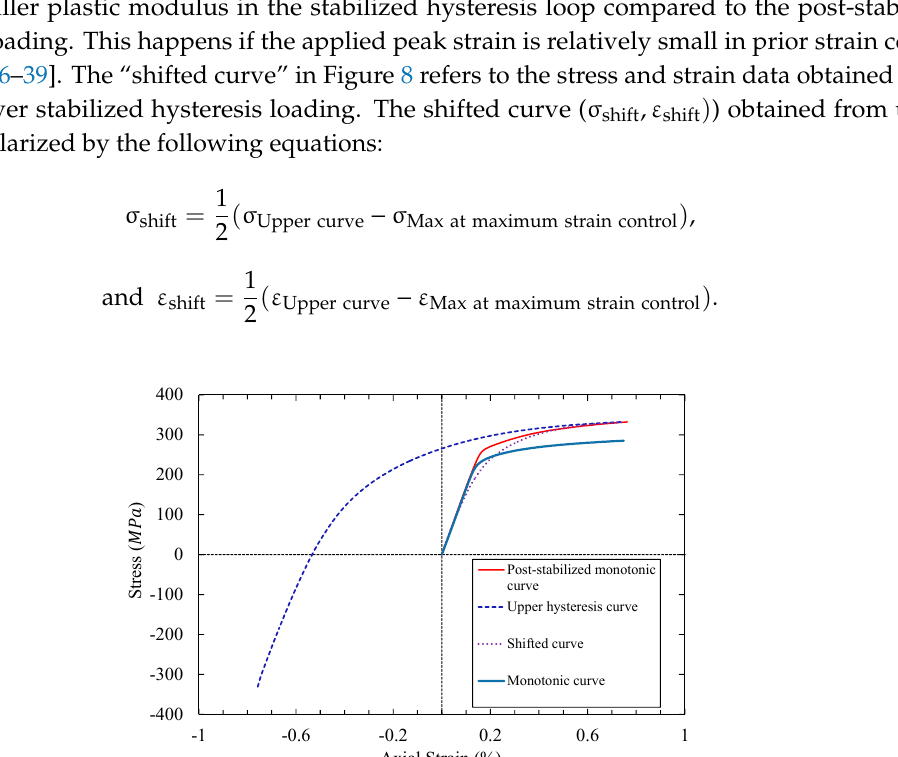
Figure 8. Monotonic, post-stabilized monotonic curves, upper hysteresis curve and shifted curve of AISI 316L SS.